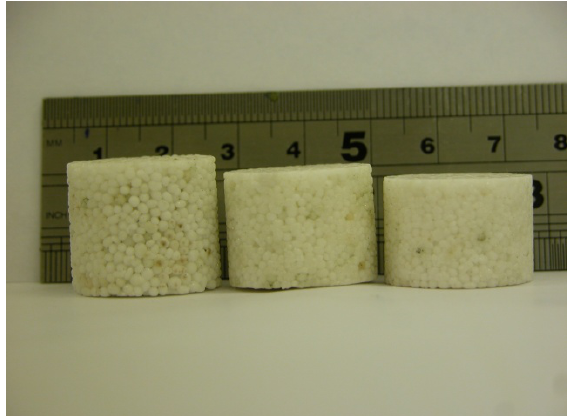
Figure 2. NaCl bead preforms (each is 12 g) compacted at different pressures from left to right, at 32, 39 and 50 MPa